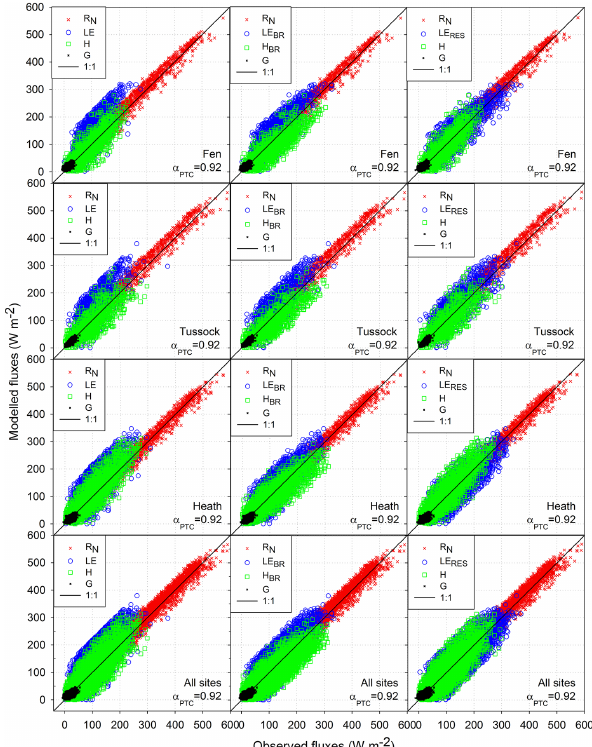
Figure 4. Comparison of modeled vs. measured half-hourly fluxes using α PTC of 0.92. The 1:1 line represents perfect agreement with observations. Columns represent results with unclosed observed tur- bulent fluxes (left), Bowen ratio closure (middle) and residual clo- sure (right) for the Fen, Tussock, Heath sites and all sites combined